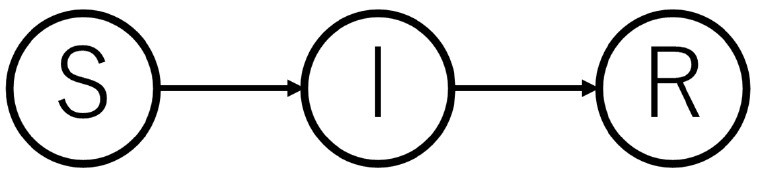
Figure 1. SIR model flow chart .